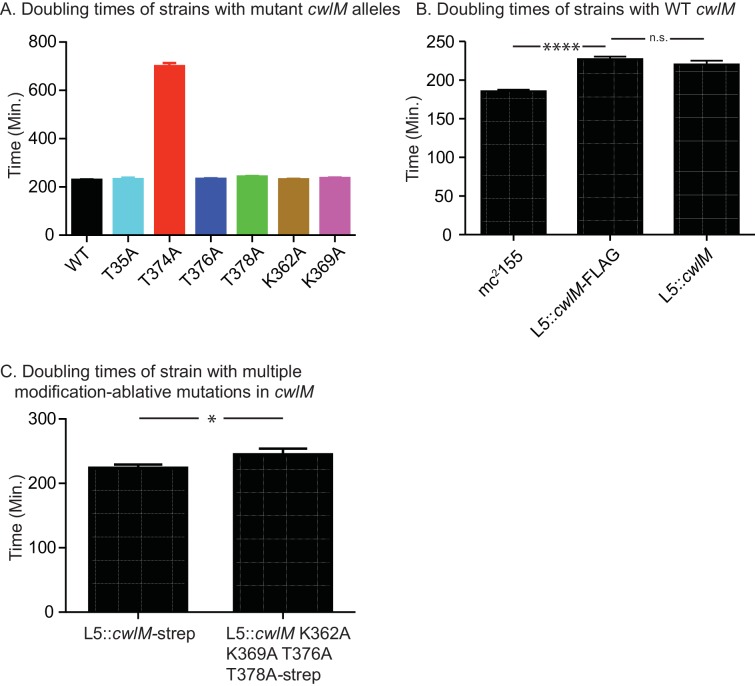
Growth rates of strains with different cwlM alleles.(A) Doubling times of ∆cwlM Msmeg strains with different cwlM-FLAG alleles at the L5 phage integrase site. WT = CB300; T35A = CB265; T374A = CB319; T376A = CB345; T378A = CB348; K362A = CB351; K369A = CB354. p values for each mutant against the WT were calculated with the students t test: all p values were insignificant except T374A > 0.0001. (B) Doubling times of wild-type M. smegmatis mc2155 (CB1), mc2155 ∆cwlM L5::cwlM-FLAG (CB300) and mc2155 ∆cwlM L5::cwlM (CB236). p values: CB1 vs. CB300 > 0.0001; CB300 vs. CB236 = 0.8. (C) Doubling times of mc2155 ∆cwlM L5::cwlM-strep (CB663) and mc2155 ∆cwlM L5::cwlM K362A K369A T376A T378A-strep (CB675), p value = 0.033.